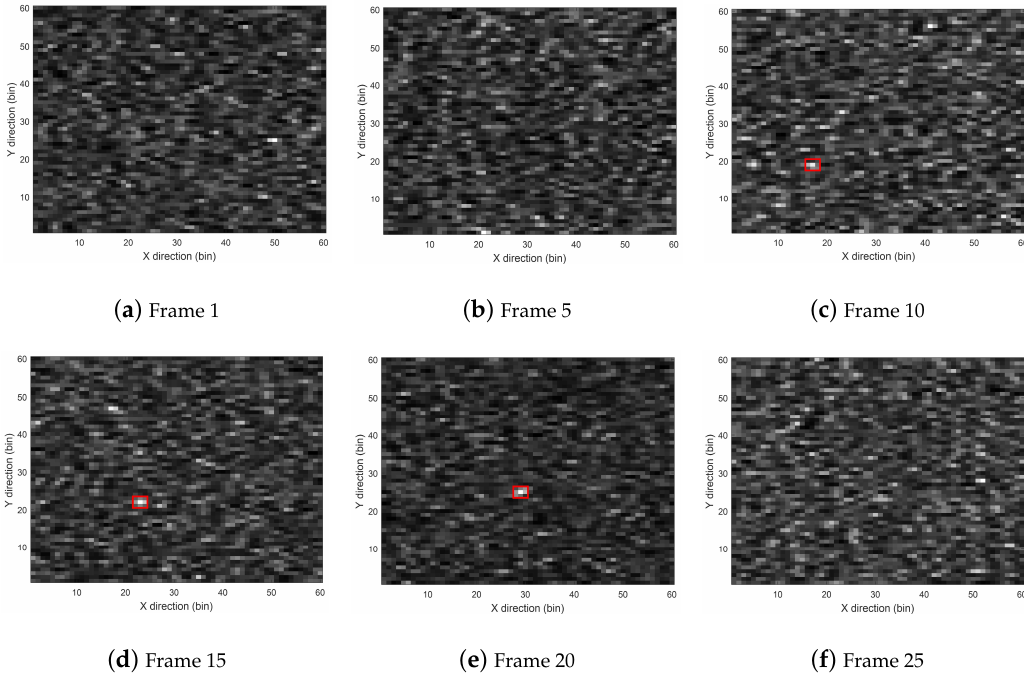
Figure 4. Sampled images at different